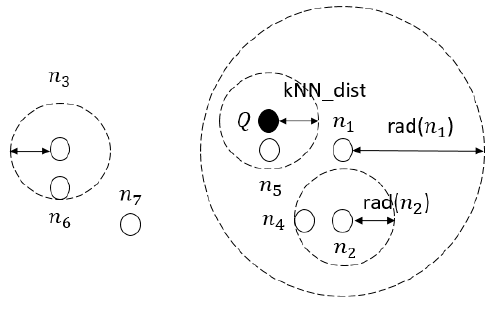
Figure 3. VP-tree concept.